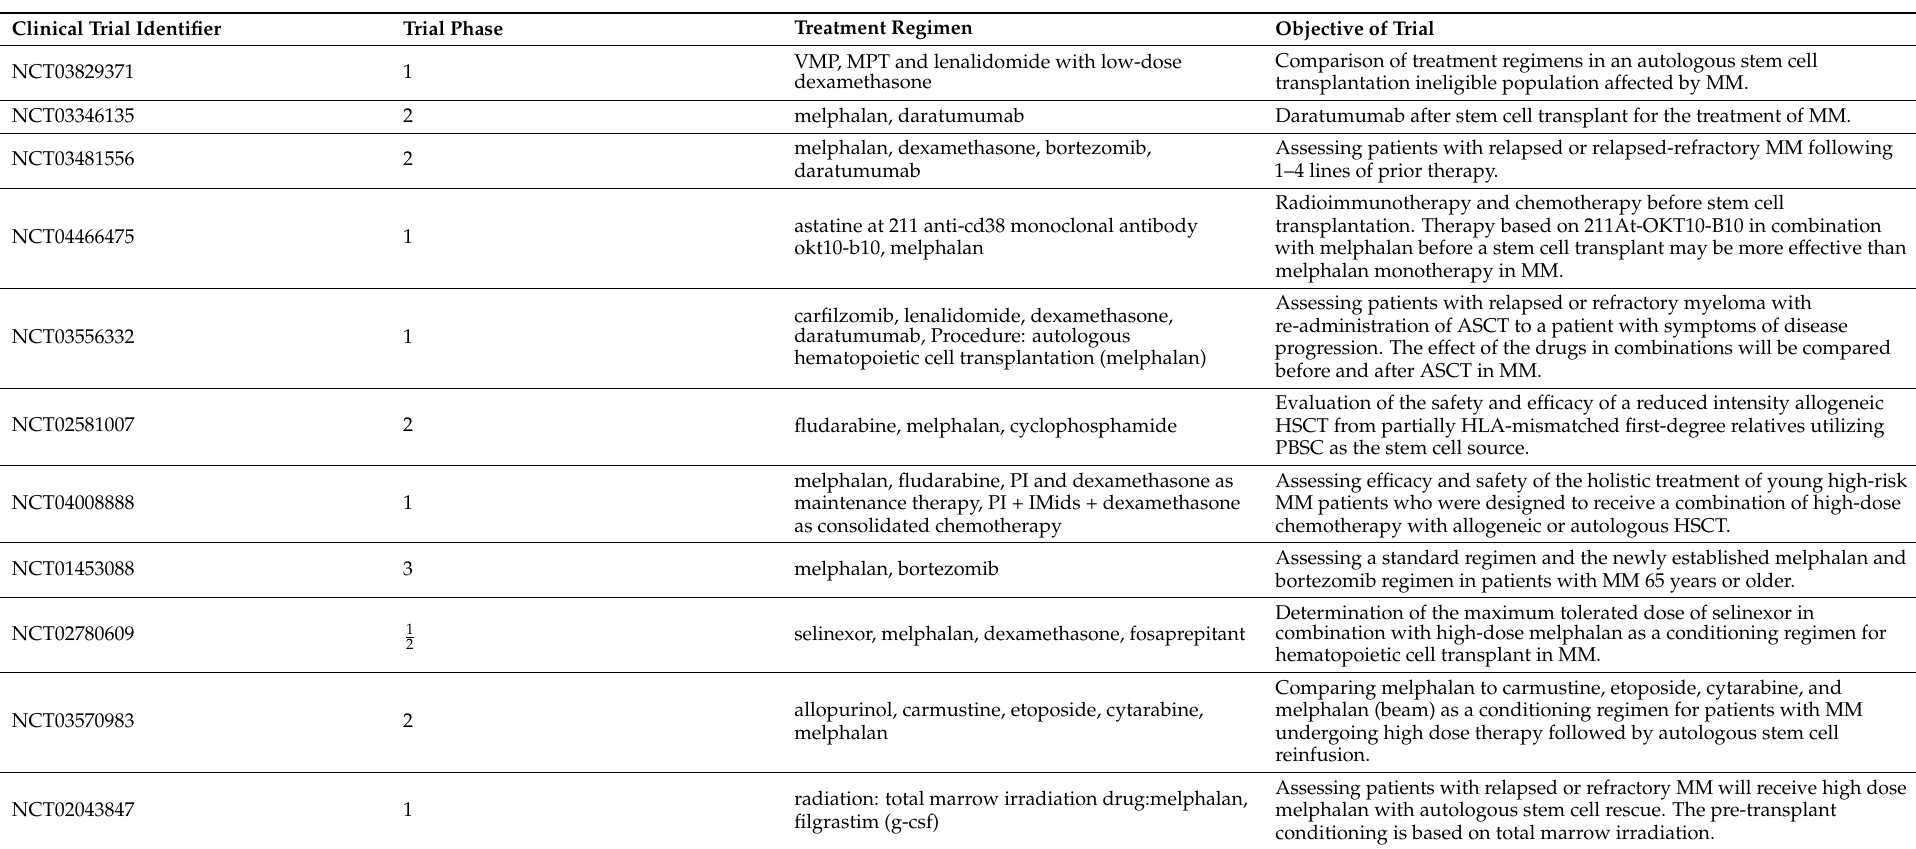
Table 3. Clinical trials assessing the efficacy of combination therapy for the treatment of MM, including melphalan-new directions. New clinical studies of the treatment of MM with combination therapy including